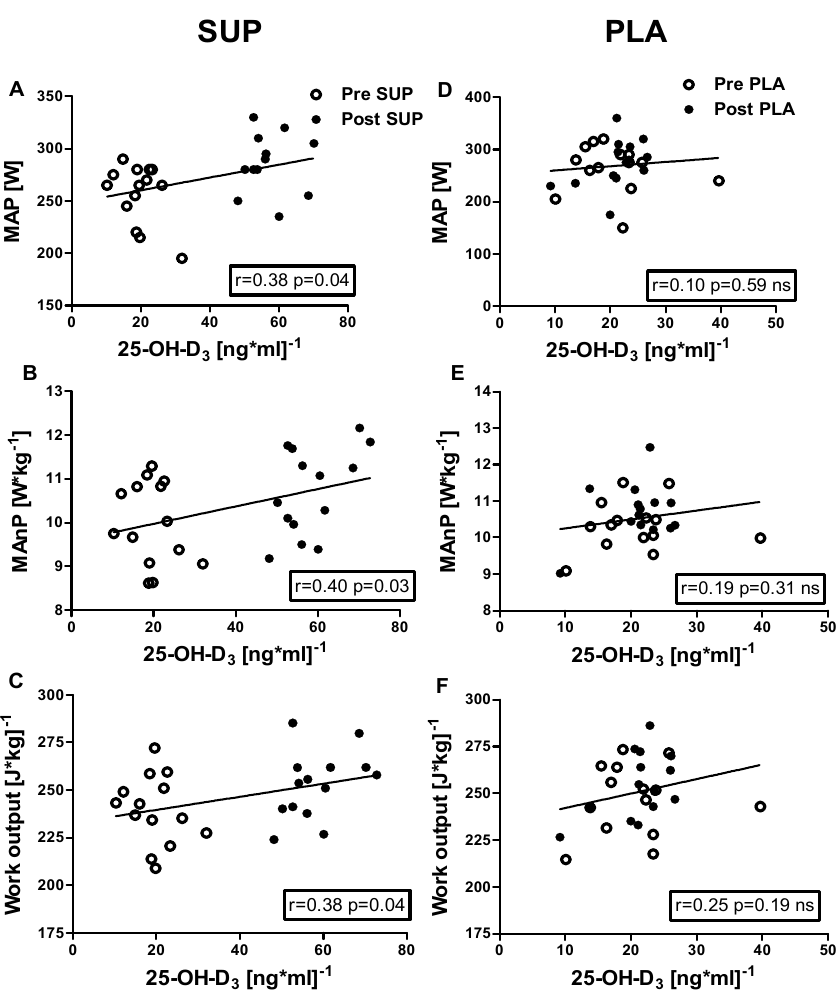
Figure 7. Association between 25-OH-D 3 and MAP, MAnP and Work output, of pre- and post-intervention in the SUP and PLA groups. Significant positive correlations between 25-OH-D 3 and MAP ( A ), 25-OH-D 3 and MAnP ( B ), and between 25-OH-D 3 and Work output ( C ) were found in the SUP group. Correlations between 25-OH-D 3 and MAP ( D ), MAnP ( E ), and Work output ( F ) in PLA group were not found. Data are presented as open circles: pre, and closed circles: post SUP or PLA. ns, non-significant.